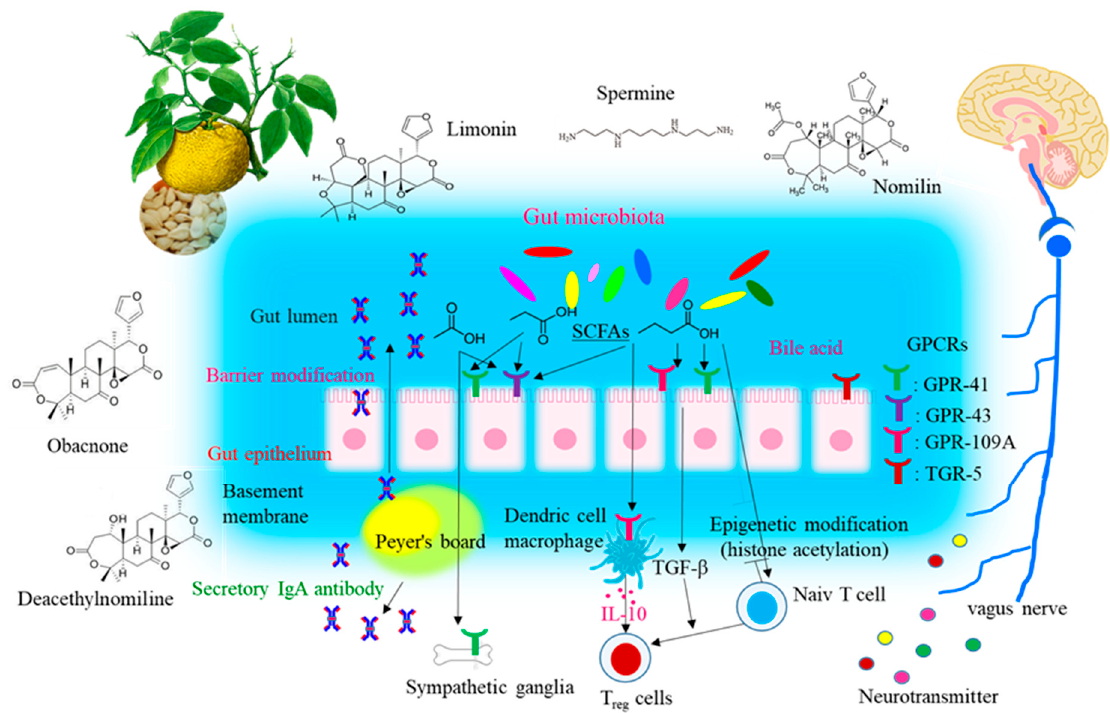
Figure 9. Conceptual diagram of immune responses of intestinal microbiota in the colon of SD and WT mice fed with limonoids + spermine or limonoids alone [56–66].